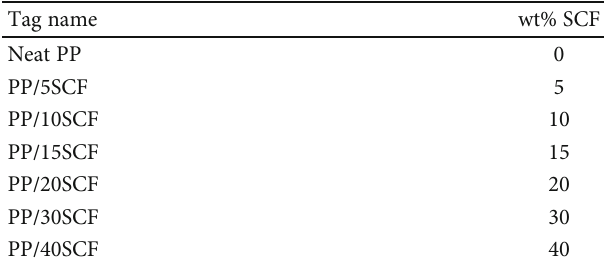
Table 3: Composition of composites containing 5 – 40wt% of